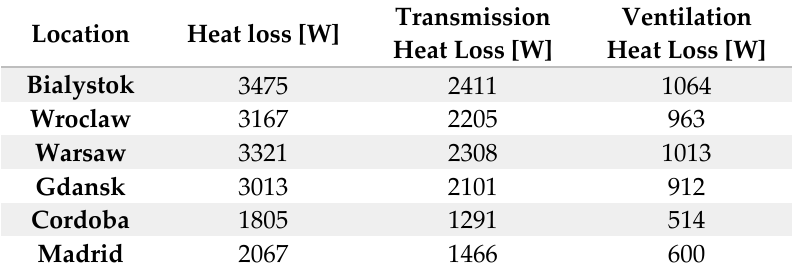
Table 1. Heat loss from the room depending on the